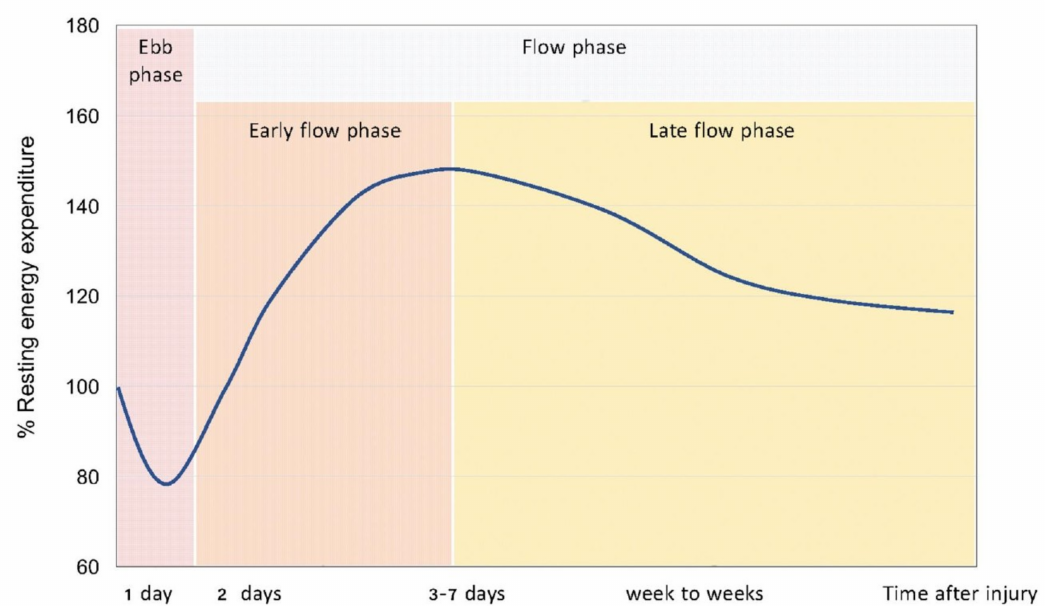
Figure 2. Metabolic response to injury proposed by Cuthbertson et al. A short ebb phase characterized by hypometabolism occurs immediately after the injury and is characterized by a decrease in metabolic rate, oxygen consumption, body temperature, and enzymatic activity. The ebb phase is followed by a longer hypermetabolic flow phase marked by an increased catabolism, with a high oxygen consumption and an elevated REE rate. Reused with permission from